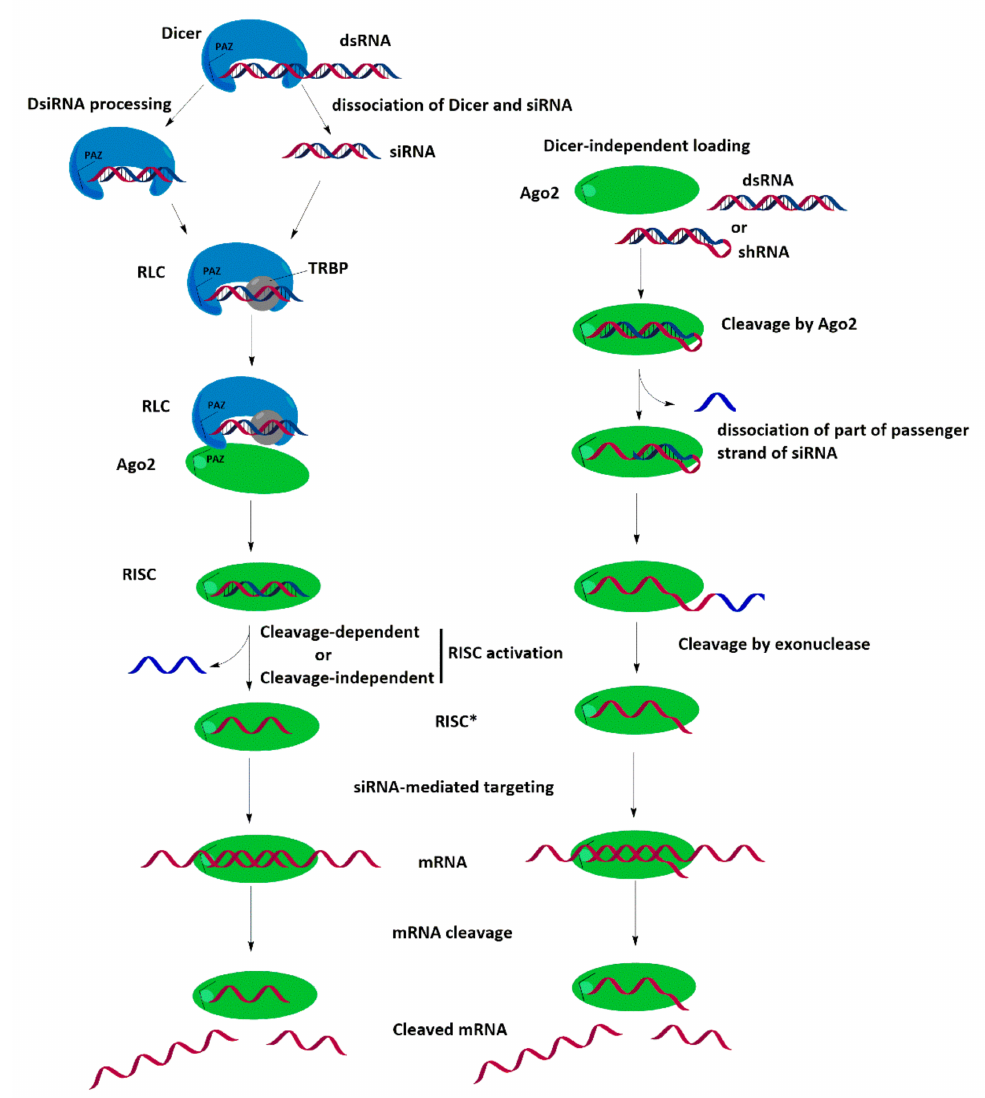
Figure 1. Dicer-dependent and Dicer-independent mechanisms of RNA